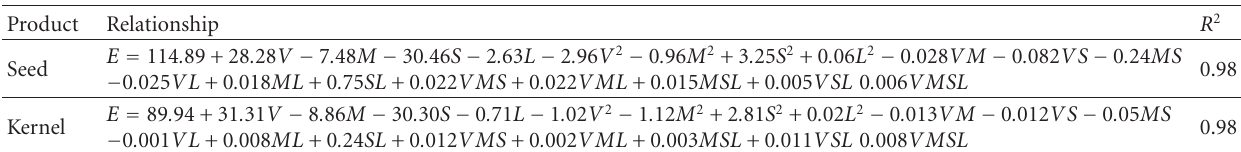
Table 4: The modulus of elasticity ( E ) of pumpkin seed and its kernel as a function of variety ( V ), moisture content ( M ), loading rate ( L ), and size category ( S